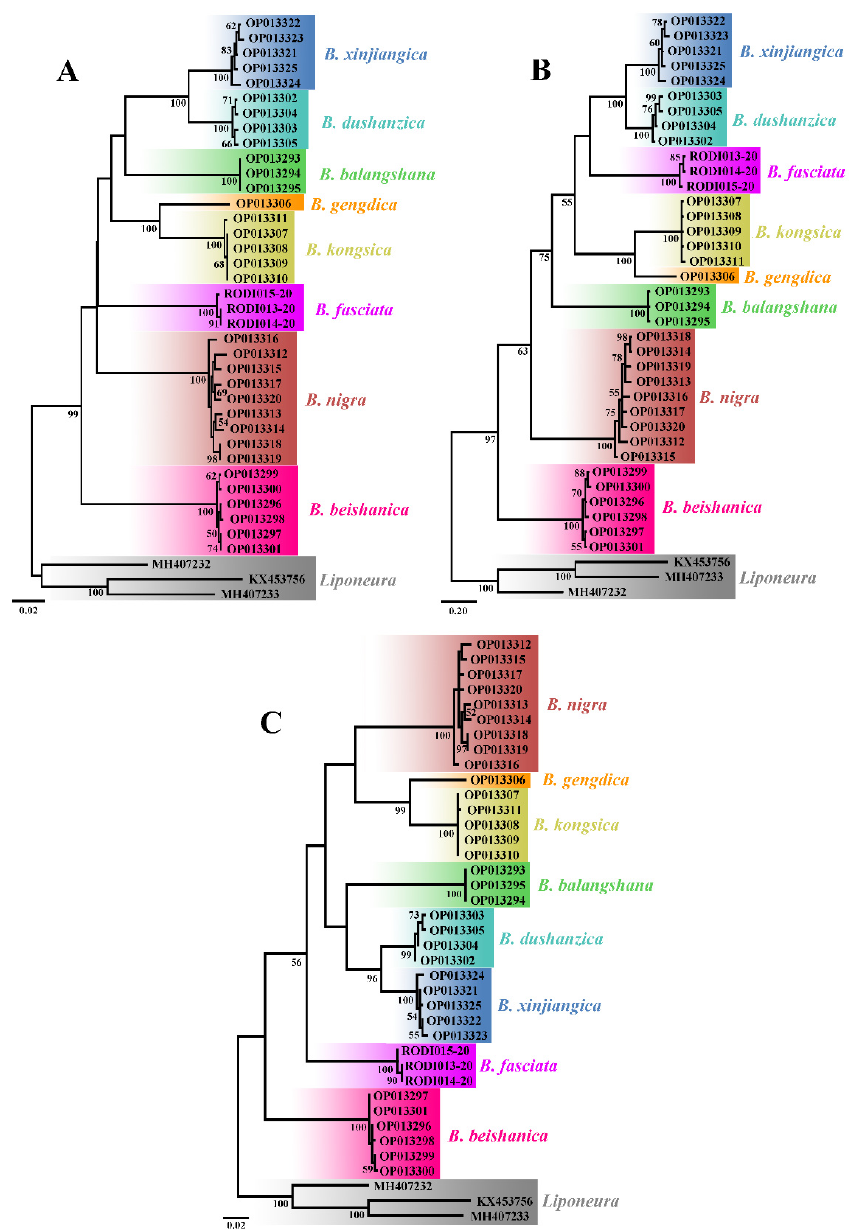
Figure 1. Neighbor-Joining ( A ), Bayesian inference ( B ), and Maximum Likelihood ( C ) trees demon- strating the clustering of Blepharicera Macquart, 1843 COI sequences. Bootstrap values and posterior probabilities of 50 and above are